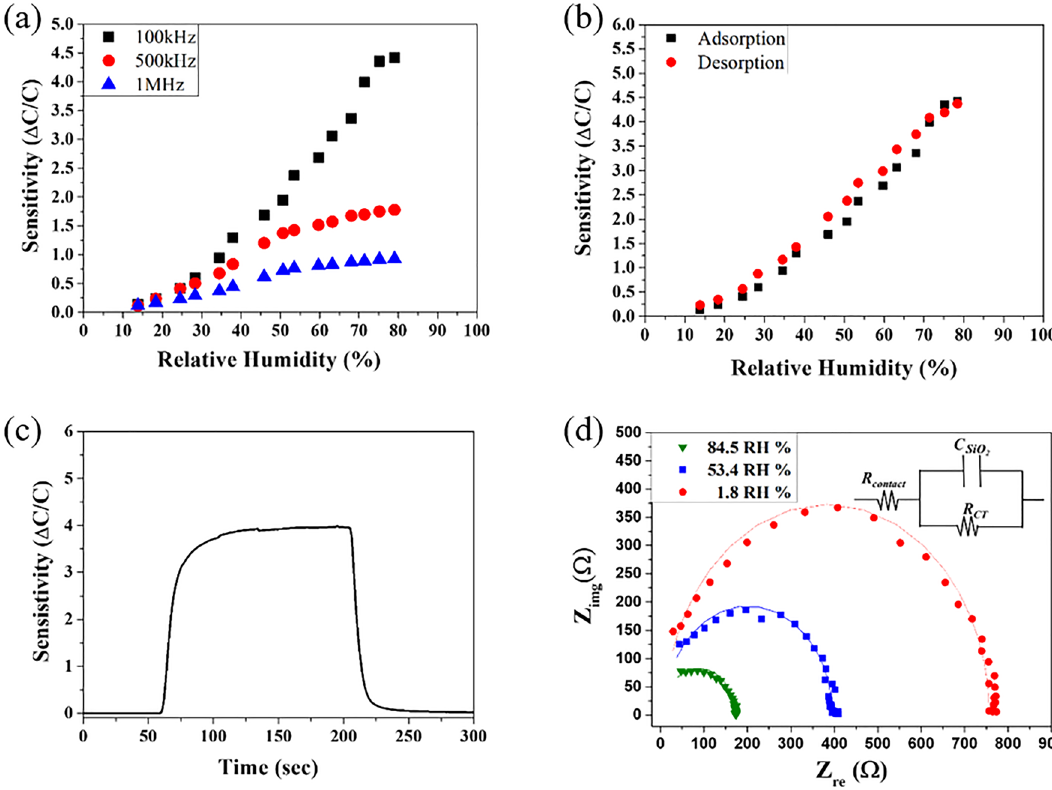
Figure 6. ( a ) Humidity sensing properties as a function of RH at the frequencies of 100 k, 500 k, and 1 MHz, ( b ) hysteresis characteristics for the adsorption and desorption at a frequency of 100 kHz, ( c ) a single sensing curve at 100 kHz in 71.4% RH, and ( d ) Nyquist plots for the RH levels of 1.8%, 53.4% and 84.5% (inset: the equivalent circuit model of the porous SiO 2 /Si